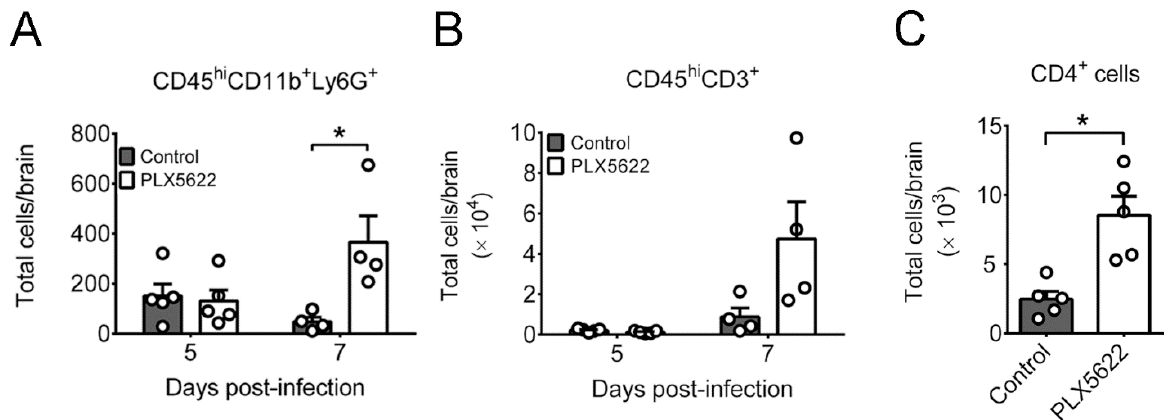
Figure 4. Effects of PLX5622 on leukocyte levels in brains of infected mice. Brains of infected mice fed with control chow or the chow containing PLX5622 were harvested on the indicated days or day 7 post-infection and assayed for ( A ) markers of neutrophils (CD45 hi CD11b + Ly6G + ), ( B ) T (CD45 hi CD3 + ) cells, and ( C ) CD4 + T cells by flow cytometry. The data represent means + SEM (error bars) of 4-5 samples per group obtained from at least two independent experiments. *, p < 0.05.